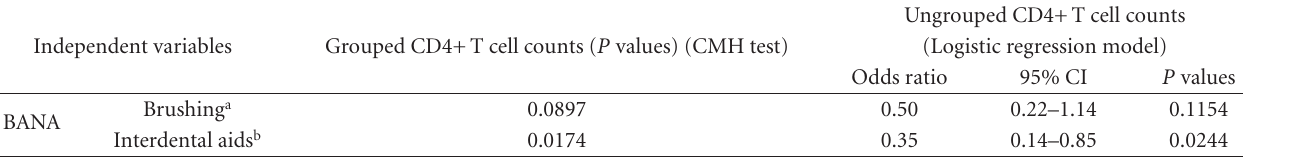
Table 4: Association between BANA with oral hygiene adjusted for grouped and ungrouped CD4+T cell counts.